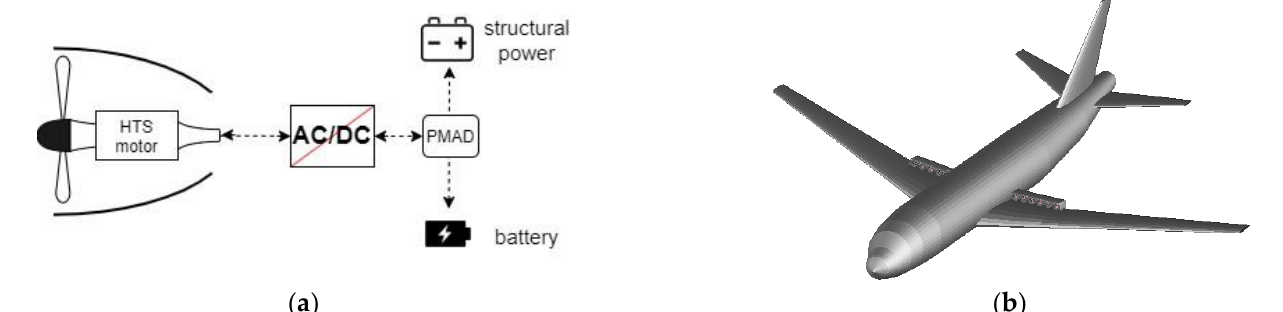
Figure 2. ( a ) Distributed propulsion ducted fan (adapted from [22,23], HTS = high-temperature superconducting, PMAD = power management and distribution system). ( b ) An all-electric aircraft with distributed propulsion designed in OpenVSP based on A320 design (adapted from [24]).